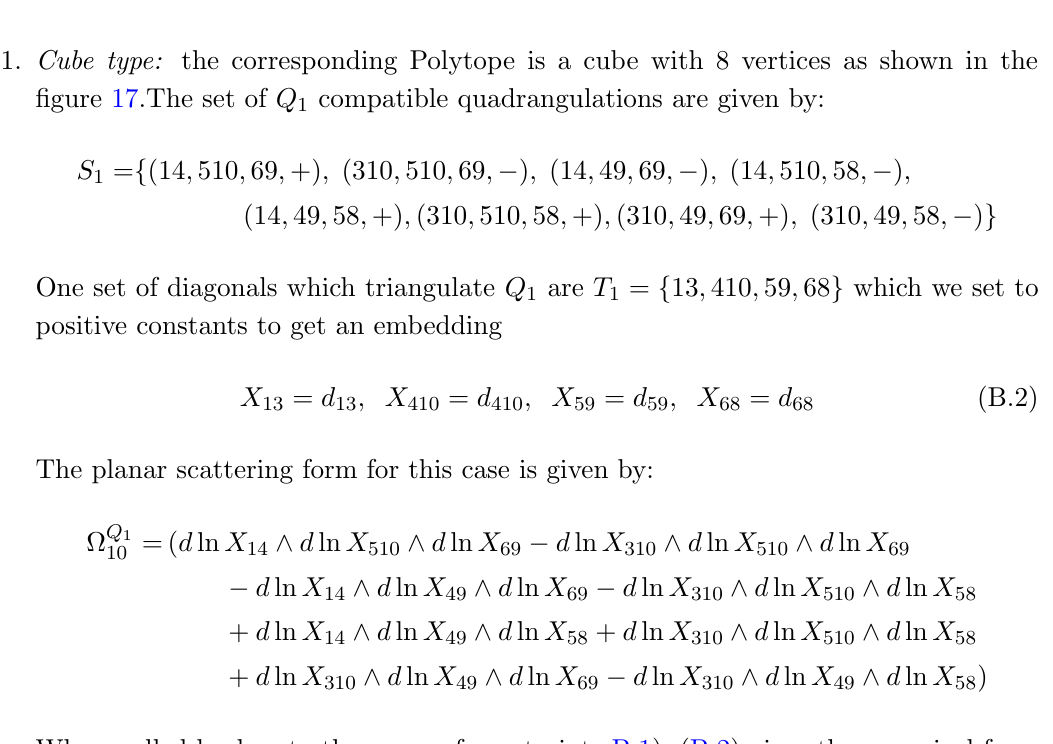
JHEP08(2019)067